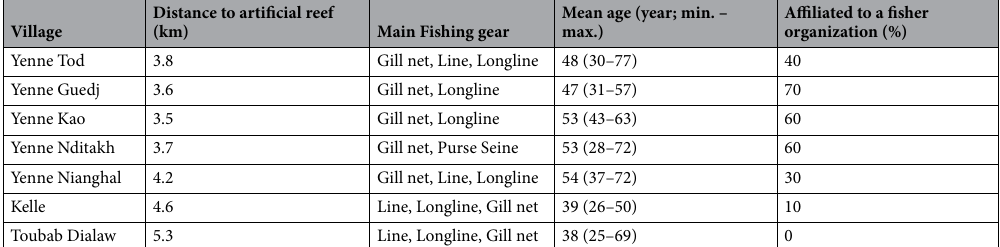
Table 2. Interviewed fishers for the sociological study conducted on June 24, 2014 in the seven village of the Yenne Municipality communities located ~ 30 km south of Dakar (Senegal). A sample of ten (10) fishers were interviewed in seven village where fishers operate around the artificial reef deployed at 14°37.032’N, 17°12.007’W. The distance from the artificial reef of each village is displayed, the main fishing gear used by the fishers and their average age, and the percentage of interviewed fisher affiliated to fisheries management body.